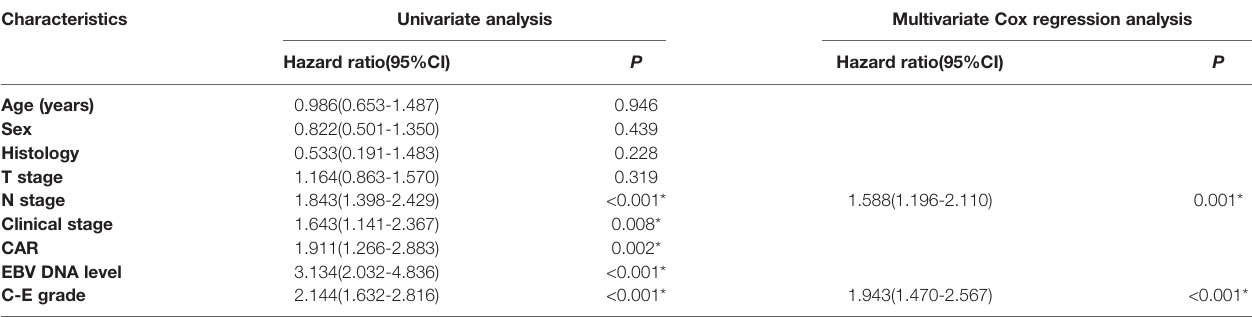
TABLE 4 | Univariate and multivariate analyses of distant metastasis-free survival in the whole cohort.